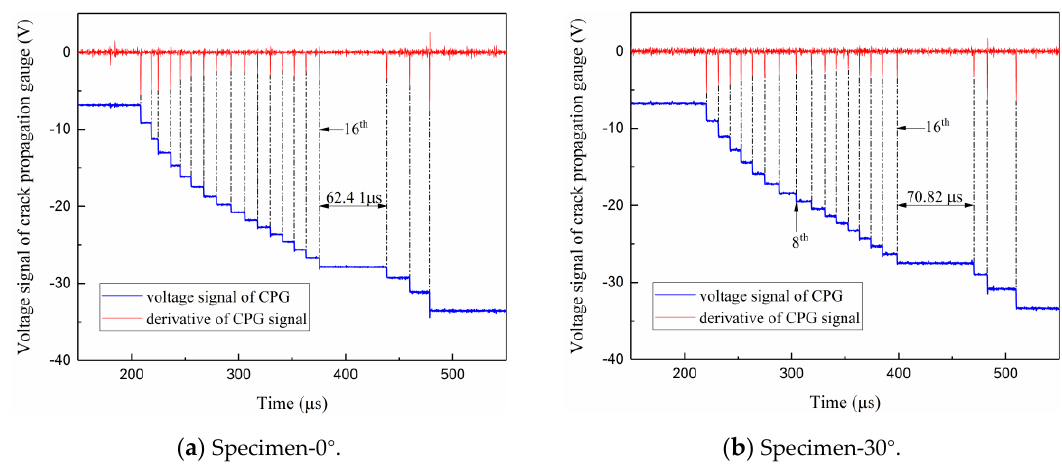
Figure 5. Crack propagation gauge (CPG) signal and derivative of CPG signal. ( a ) CPG signal curve of specimen-0°. ( b ) CPG signal curve of specimen-30°.